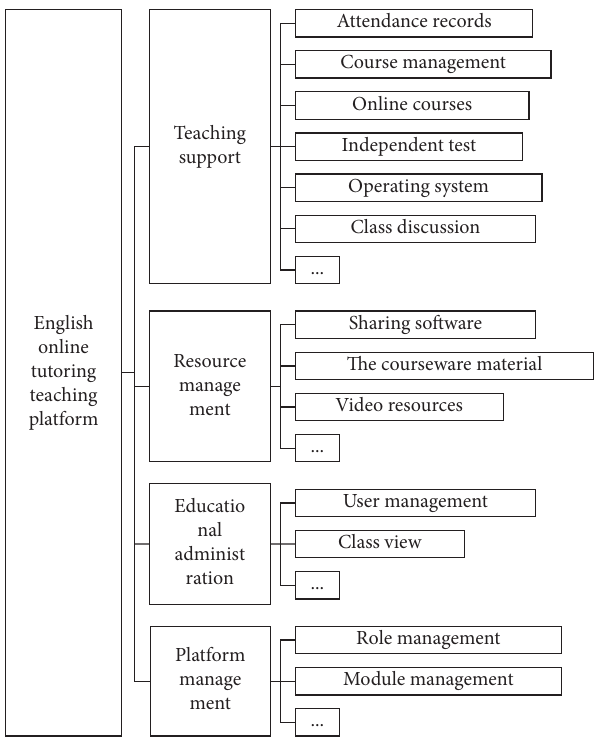
Figure 2: Main function structure of